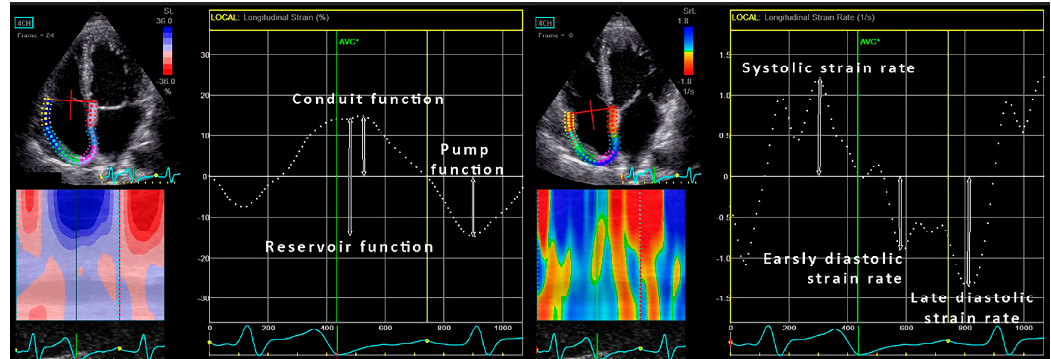
Figure 2. Right atrial strain and strain rate analysis in the four-chamber view.